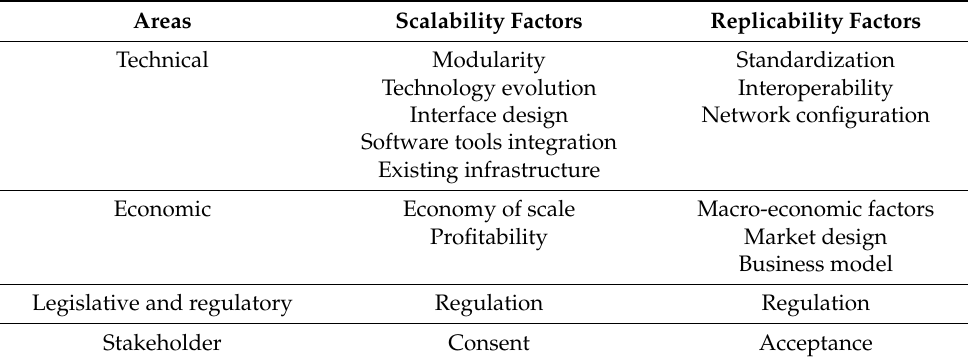
Table 1. Scalability factors. Adapted from Ref. [26], May et al. (2015, p.